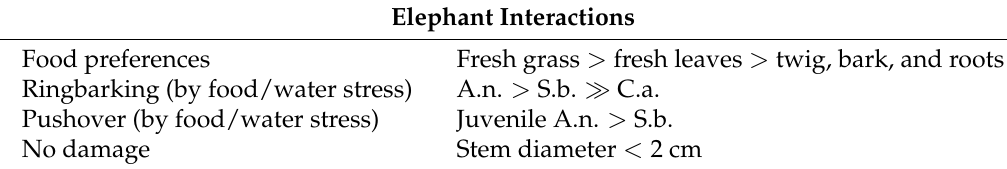
Table A4. Ranking of Elephant